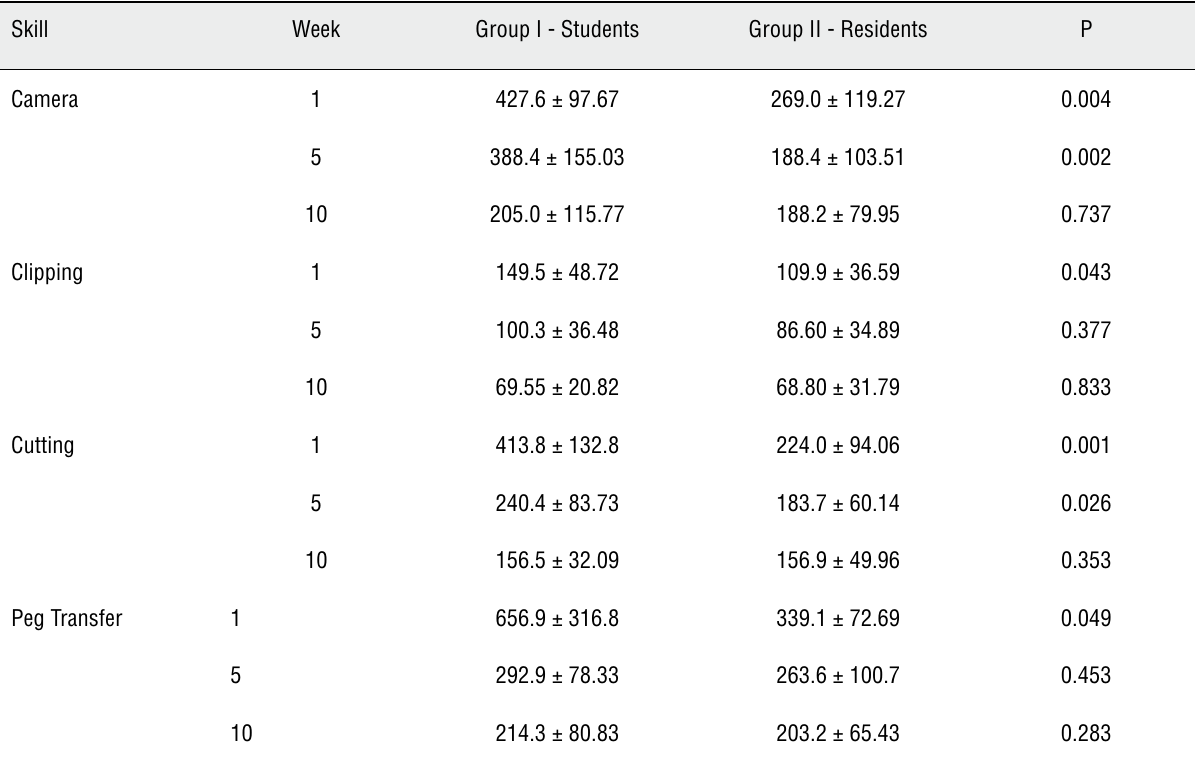
Table 1 - Average time (in seconds) for completion of the exercise and standard deviation. - Level 02.